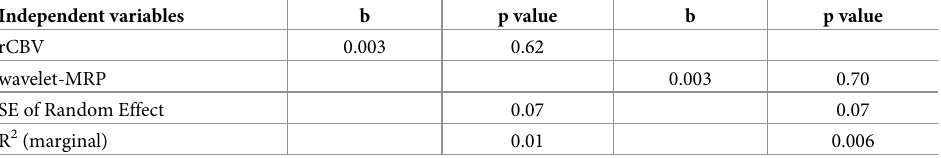
Table 3. Predictors of MIB-1 staining ratio. Mixed linear regression with the Ki67 staining ratio as outcome and either rCBV or waveletMRP as predictor for all included matching tissue